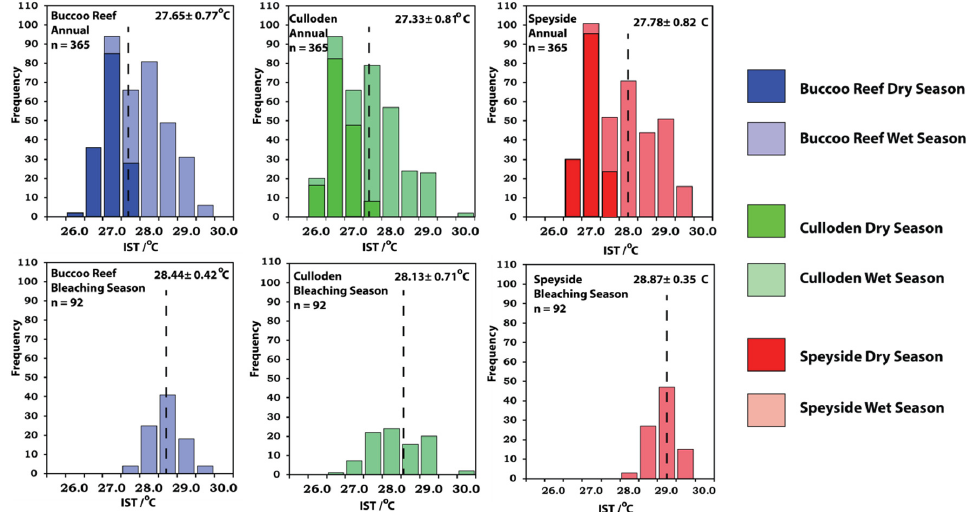
Figure 3. Histograms of in situ temperature (IST) recorded at three reefs off Tobago for annual (2014) and during the bleaching season (August to October, a subset of the wet season). Dashed line shows the temporal mean, also shown numerically with one standard deviation.